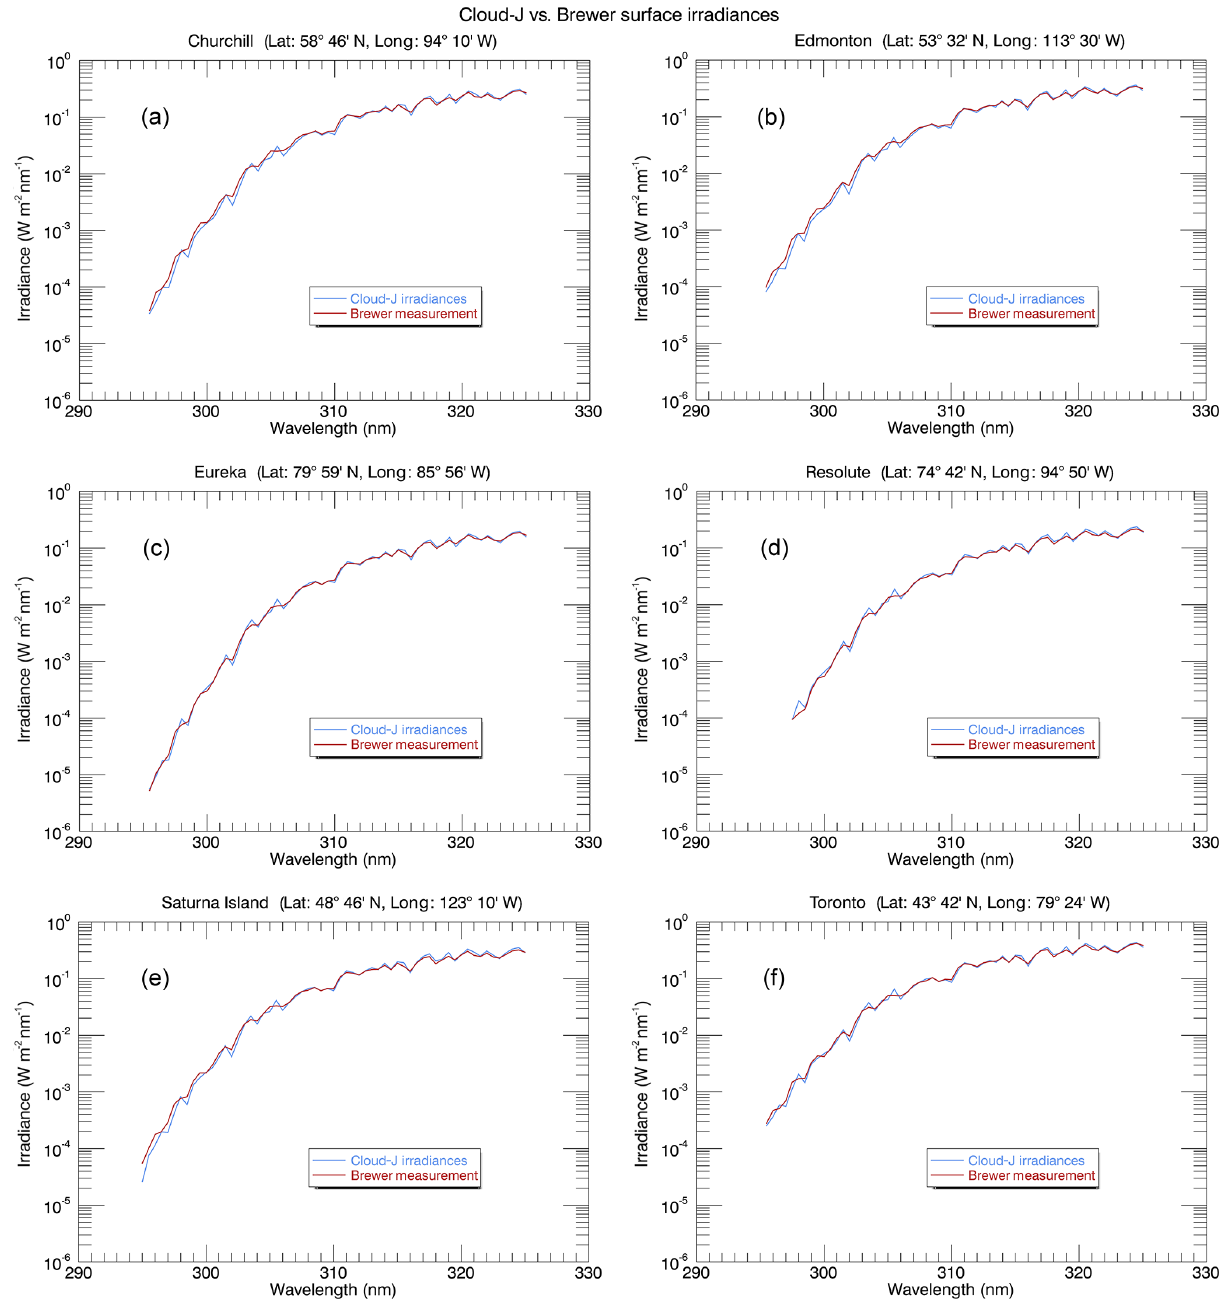
Figure 4. Cloud-J clear-sky surface irradiances compared to in situ Brewer measurements obtained from six measurement stations belonging to ECCC’s ozone monitoring network. Plotted are 5-day averages for 18:00UTC of Brewer spectral irradiances (red curve) and the associated Cloud-J irradiances (light blue). The Cloud-J irradiances shown here were calculated with the Dobber et al. (2008) TOA spectrum averaged over 0.5nm intervals with a sampling resolution also of